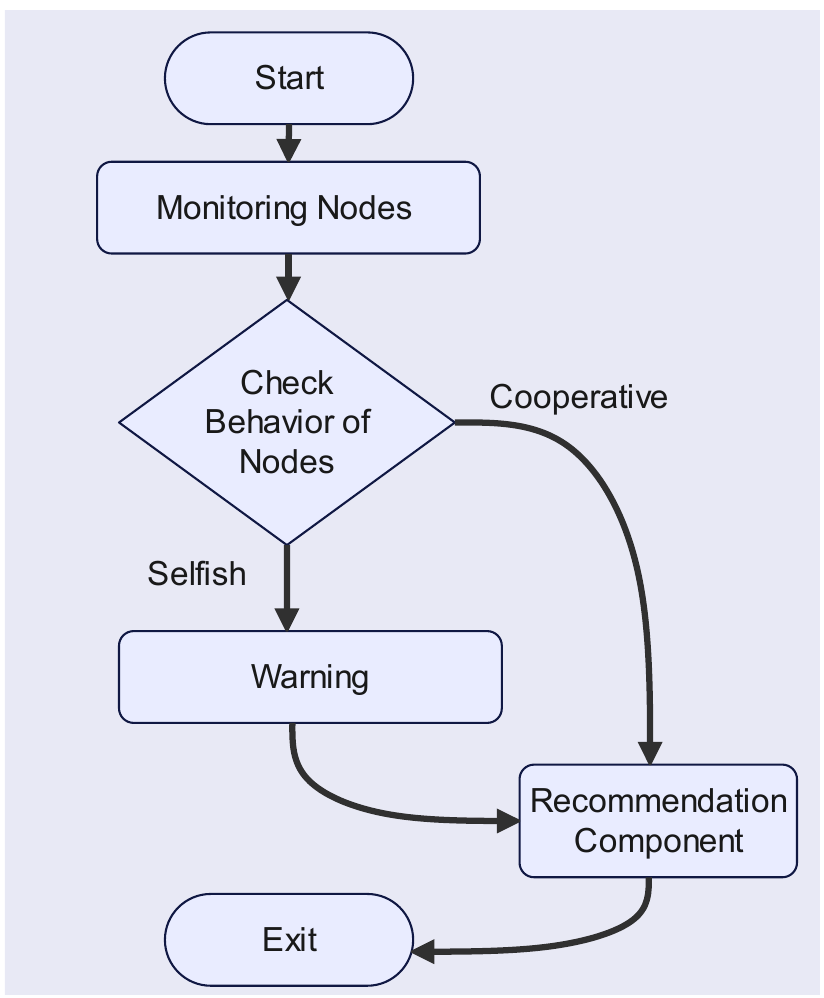
Figure 4. Flow Chart of the Punishment